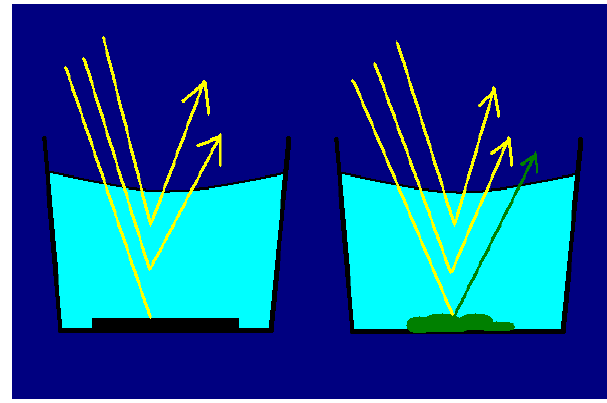
Figure 3 : An illustration comparing the reflected upwelling energy from water tanks with two different bottom types, a black panel and vegetation.